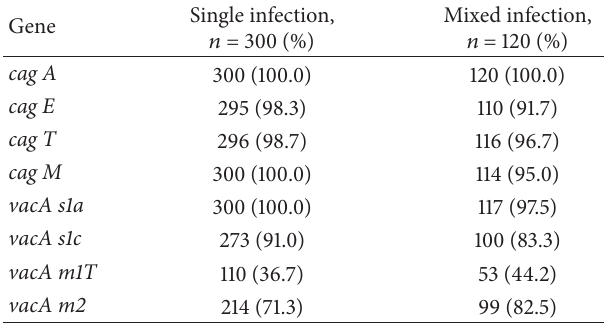
Table 2: PCR analysis for cag -PAI status and the s-region or m- region of vac A in single and mixed infections of H. pylori .